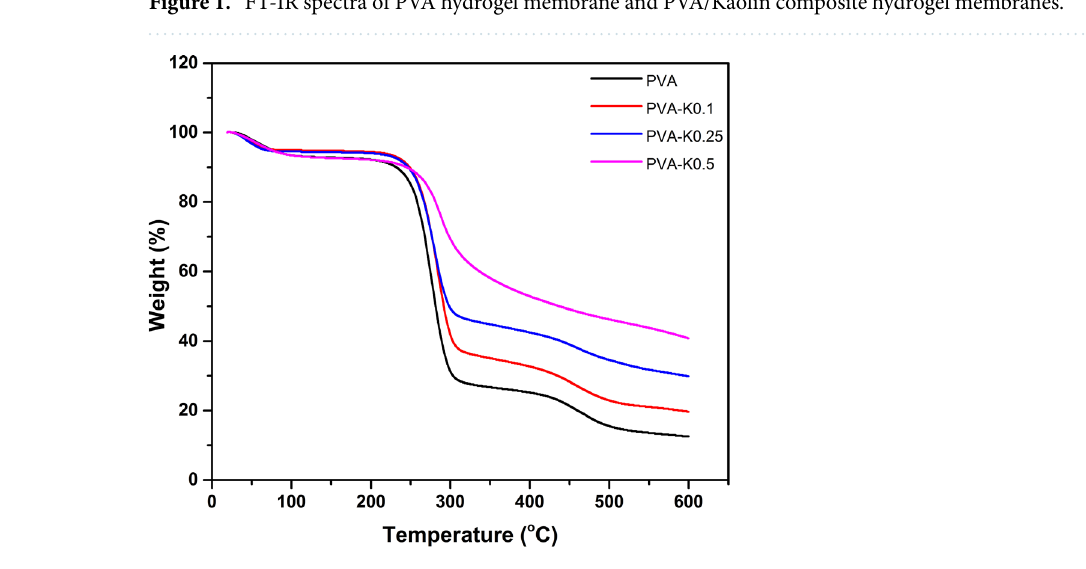
are in line with those of the previous study 29 . The weight loss level for the PVA membrane was the highest in